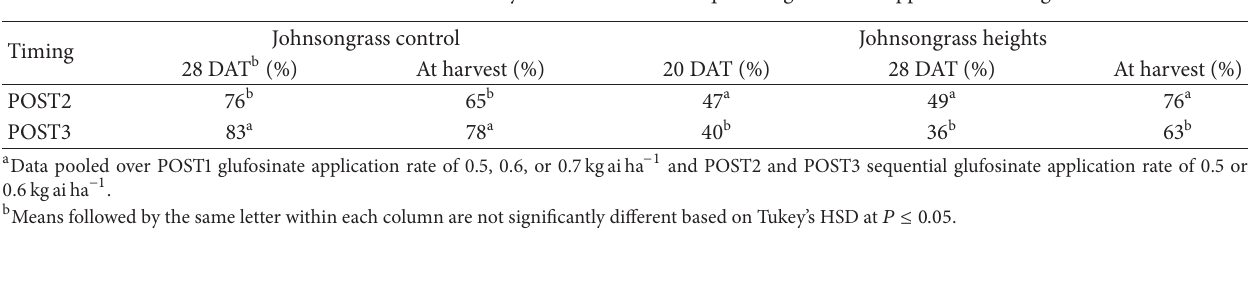
Table 4: Glyphosate-resistant rhizomatous johnsongrass heights as apercentofthenontreated28 daftertreatment(DAT)andatharvest and soybean yield as influenced by POST2 and POST3 sequential glufosinate application rate.